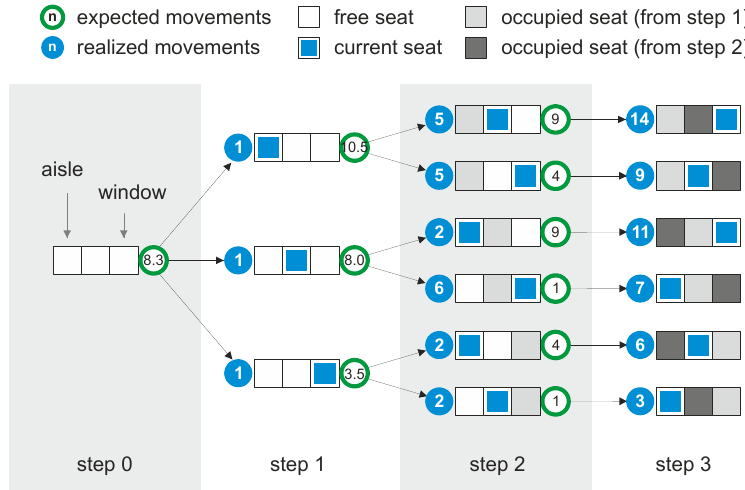
Figure 1. Seat row progress (aisle seat right, window seat left) indicating movements/interactions expected (green circle) and realized (blue circle).